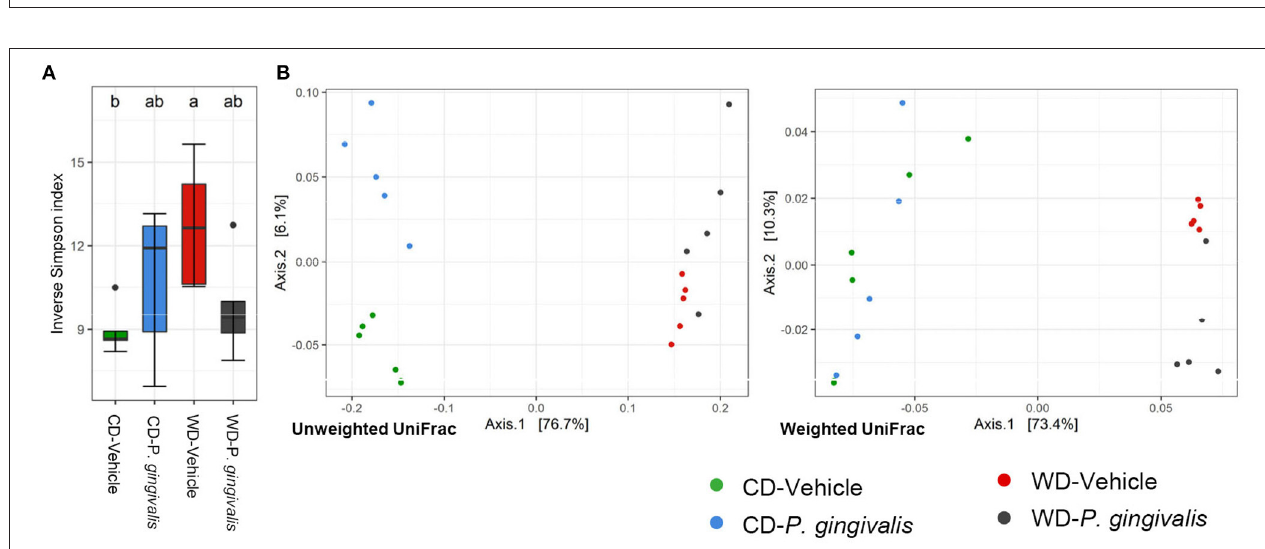
FIGURE 4 | Chronic P. gingivalis infection alters microbial community abundance of mice fed a Western diet. Results of 16S rRNA gene sequencing of the cecal microbiota. (A) Inverse Simpson index measuring alpha diversity. Groups with different letters (a, b) are significantly different. (B) Unweighted and weighted UniFrac measurement of beta diversity with significance measured by PERMANOVA. Unweighted: all groups: R 2 = 0.7332, p < 0.001; P. gingivalis vs. vehicle-treated mice fed a WD: R 2 = 0.1743, p = 0.169; P. gingivalis vs. vehicle-treated mice fed a CD: R 2 = 0.3505, p = 0.026. Weighted: R 2 = 0.7332, p < 0.001; P. gingivalis vs. vehicle-treated mice fed a WD: R 2 = 0.1743, p = 0.169; P. gingivalis vs. vehicle-treated mice fed a CD: R 2 = 0.3505, p =